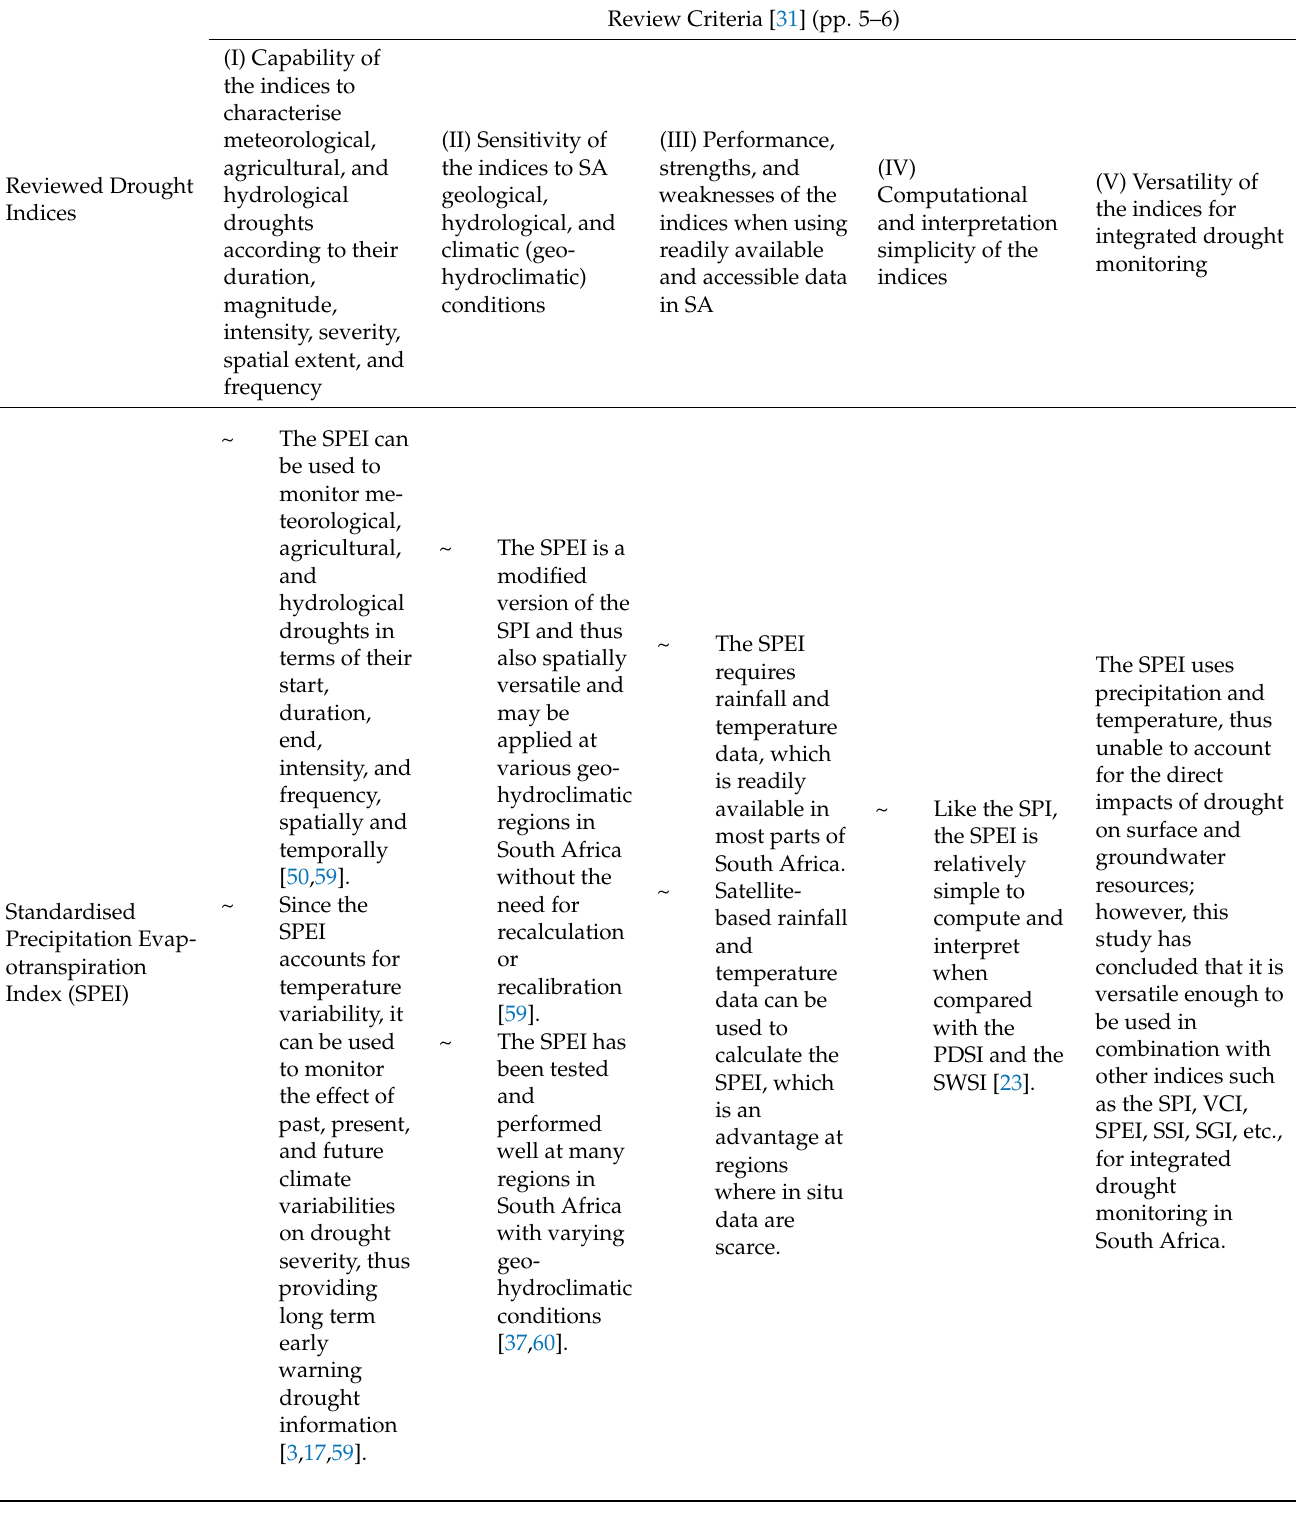
Table 4. Review of the SPEI based on the 2016 WMO Handbook of Drought Indicators and Indices [31] (pp.